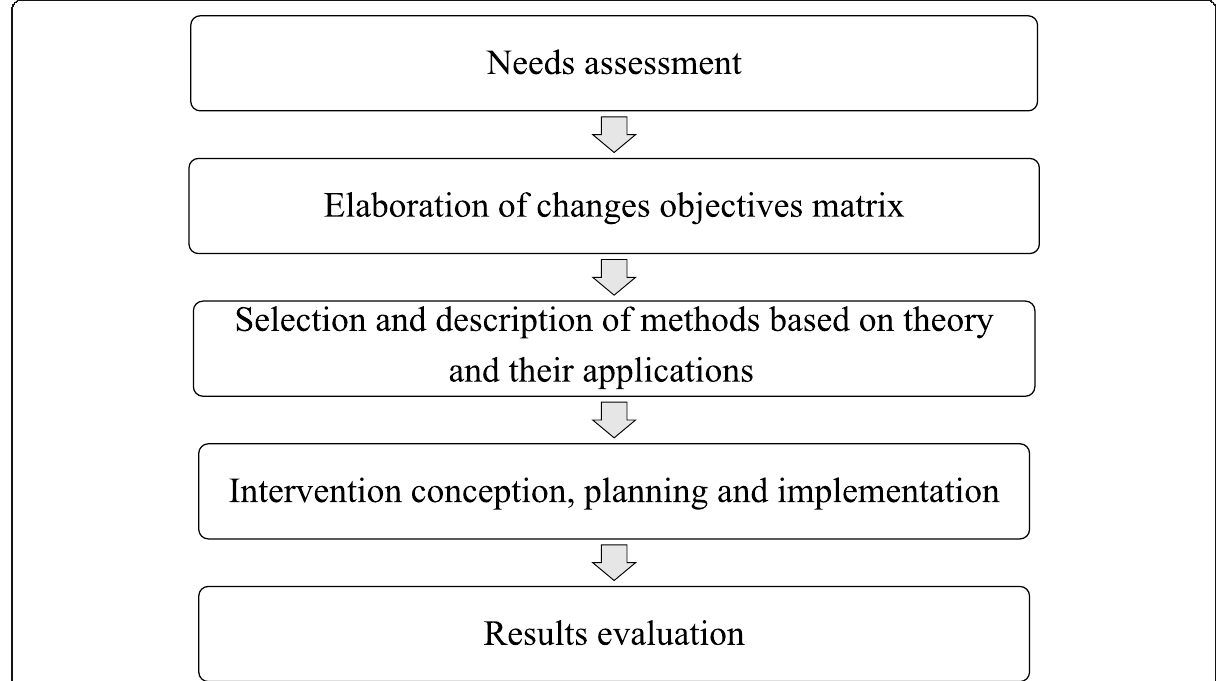
Fig. 1 Flowchart of intervention planning, implementation and evaluation